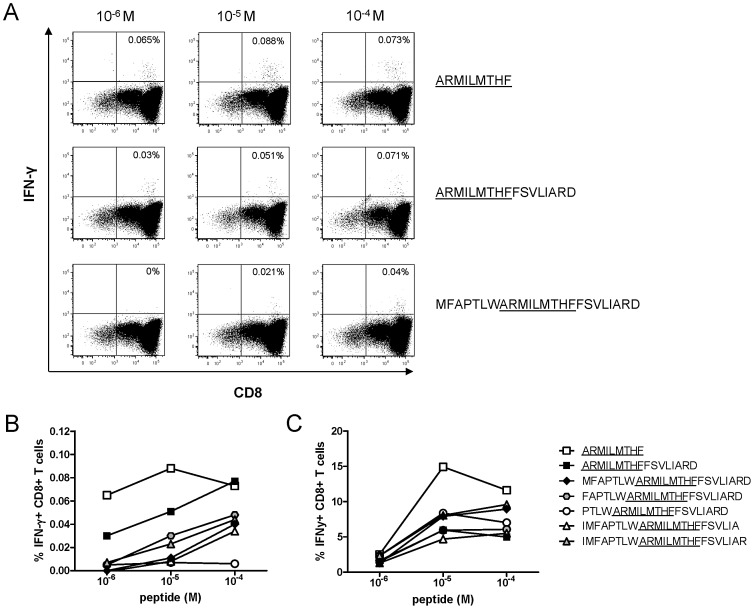
Cross-recognition patterns of all B27-NS5B2841-containing fragments derived from immunoproteasomal digestion.(A) Representative flow cytometry plots showing intracellular IFN-γ staining with CD8+ T cells from one subject across a range of peptide concentrations. PBMCs from HLA-B*27+ subjects chronically infected with HCV were enriched for CD8+ T cells and expanded non-specifically for 14 days. The background value from the negative control (without peptide loading) was subtracted from all measured response frequencies (IFN-γ+ CD8+/total CD8+). Tested peptide sequences are indicated. (B) Representative cross-recognition patterns of all naturally processed B27-NS5B2841-containing fragments by enriched and non-specifically expanded CD8+ T cells (see Figure 7A). Responses were measured by intracellular IFN-γ staining against serial dilutions of all 7 B27-NS5B2841-containing peptide forms. The background value from the negative control (without peptide loading) was subtracted from all measured response frequencies (IFN-γ+ CD8+/total CD8+). Symbol code for peptide sequences is indicated in Figure 7C. (C) Representative cross-recognition patterns of the NS5B2841- peptide by PBMCs specifically expanded by all naturally processed B27-NS5B2841-containing fragments. PBMCs from subjects chronically infected with HCV were stimulated for two weeks with all 7 B27-NS5B2841-containing peptide forms separately (see indicated symbol code). Responses were measured by intracellular IFN-γ staining against serial dilutions of the NS5B2841- peptide. The background value from the negative control (without peptide loading) was subtracted from all measured response frequencies (IFN-γ+ CD8+/total CD8+).